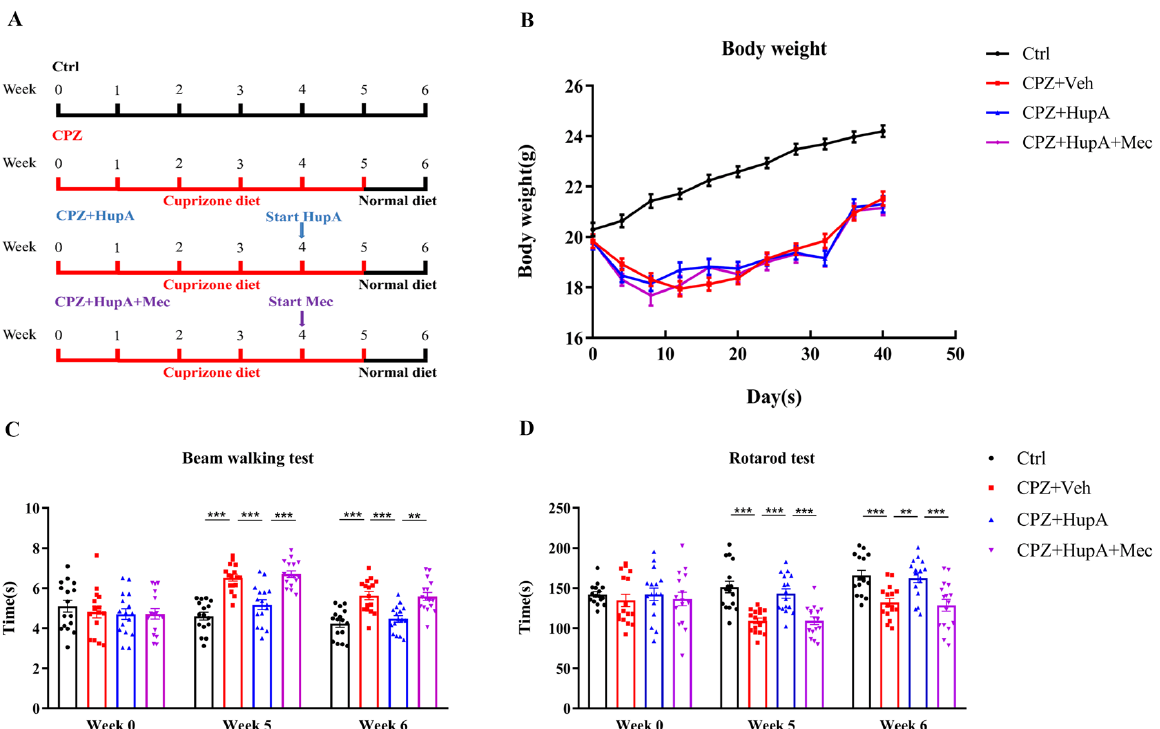
Figure 1. HupA improved motor coordination function in CPZ-induced demyelination. Mice were administered chow containing 0.3% CPZ until week 5 and were intraperitoneally injected with HupA and mecamylamine for 2 weeks of treatment from week 4 to 6 of CPZ feeding. ( A ) Administration of CPZ, HupA, and mecamylamine. ( B ) body weight change. ( C ) BWT. ( D ) rotarod test. The results represent the mean ± SEM (** p < 0.01, *** p < 0.001, n = 16 mice per group).